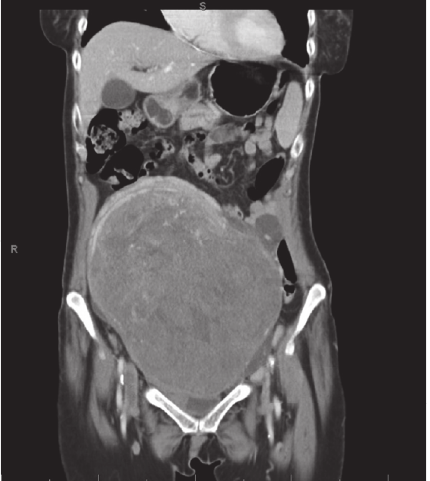
Figure 3: Abdomen-pelvis CT scan of case 2 showing large uterine